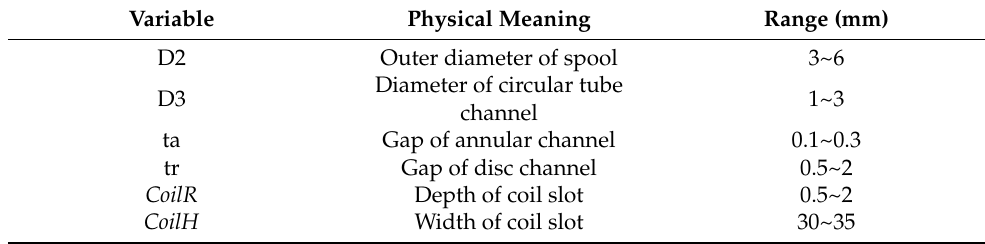
Figure 7. Structure parameters of the VSB. Table 2. The range of designed variables for the VSB.